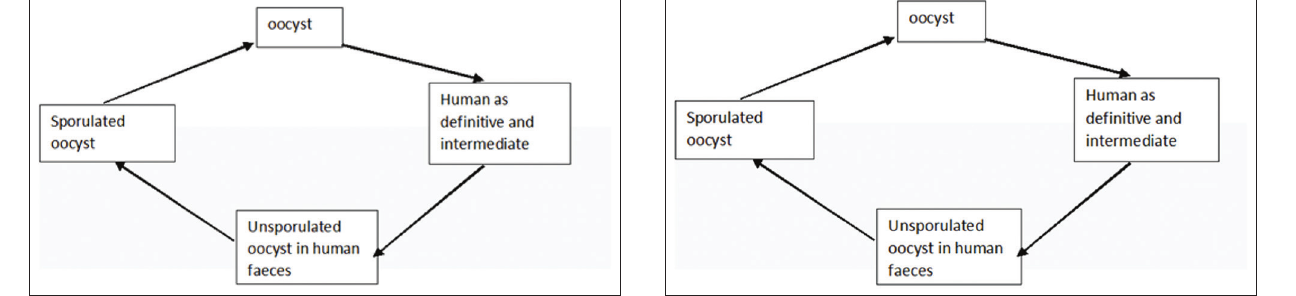
Figure-1: Life cycle of Cyclospora cayetanensis. Figure-2: Life cycle of Cryptosporidium